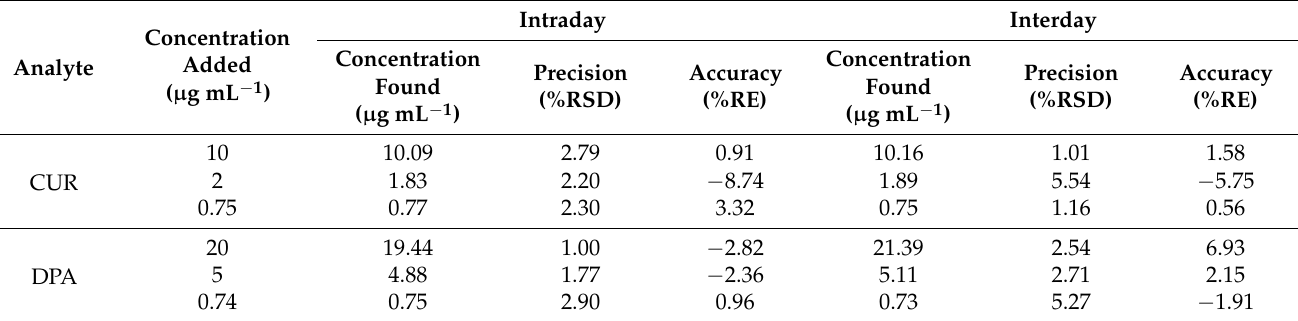
Table 3. Intraday and interday accuracy and precision of CUR and DPA in PBS (pH 7.4) (means ± SD, n =